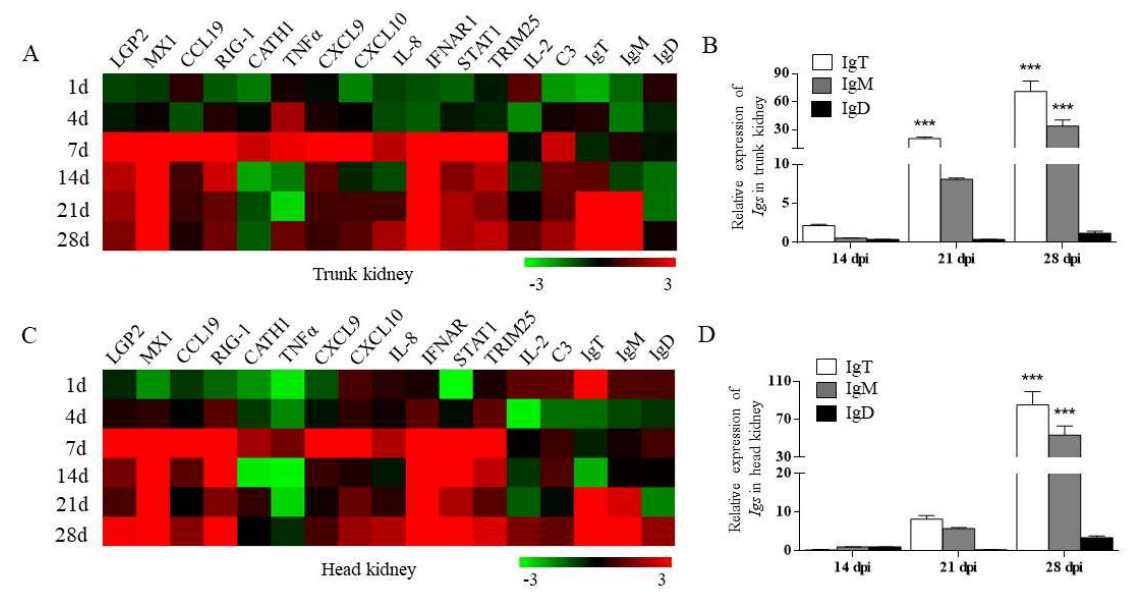
Figure 3. The relative mRNA expression of immune-related genes in the trout kidney after IHNV infection. ( A , C ) Heatmap results from qRT-PCR analysis for selected immune-related genes in trunk kidney ( A ) and head kidney ( C ) at 1, 4, 7, 14, 21, and 28 dpi ( n = 6 fish per group). ( B , D ) Relative mRNA expression of IgT, IgM, and IgD at 14, 21, and 28 dpi in rainbow trout trunk kidney ( B ) and head kidney ( D ) ( n = 6 fish per group). Data are representative of three independent experiments (mean ± SEM). * p < 0.05, ** p < 0.01, *** p < 0.001 (unpaired Student’s t-test).